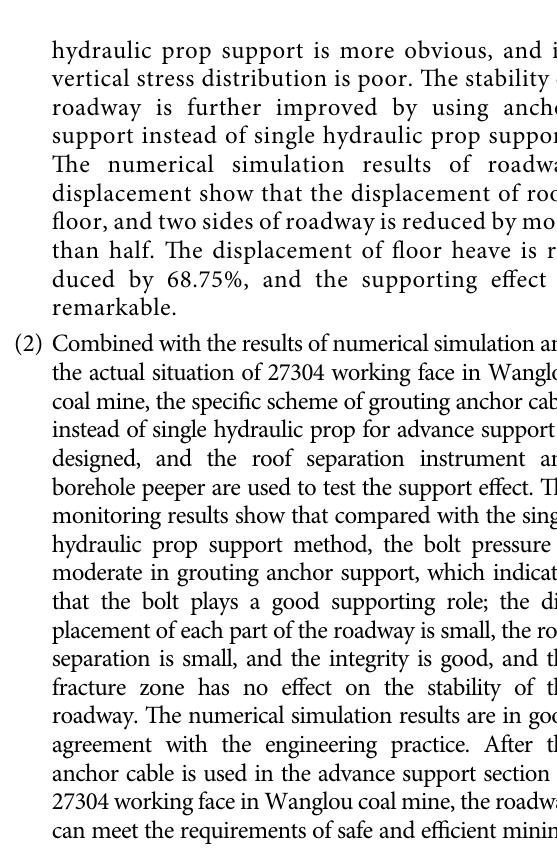
Figure 14: Distribution law of cracks in roof strata (3# drill hole).